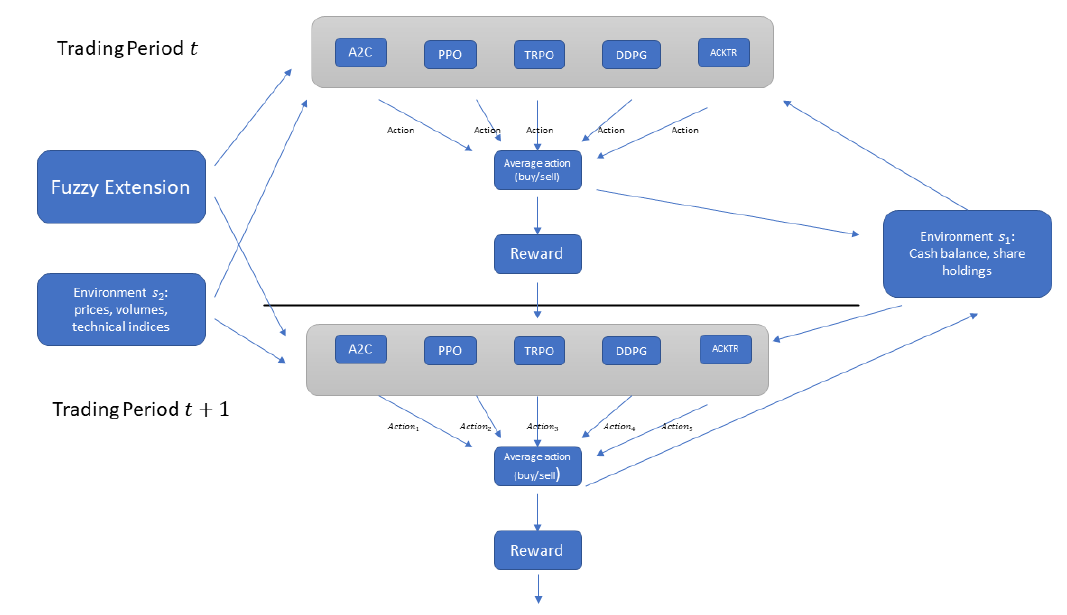
Figure 1. Model Flow Chart.